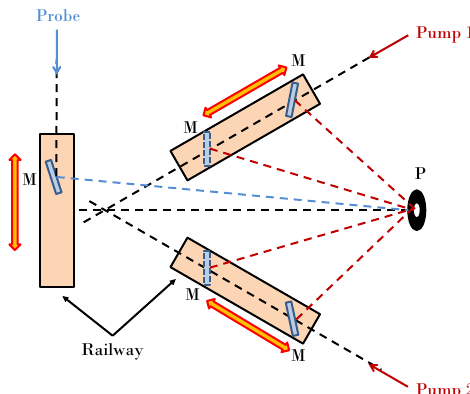
Figure 2. Optical setup for homodyne detection with continuous angles variation. M: mirrors; P: